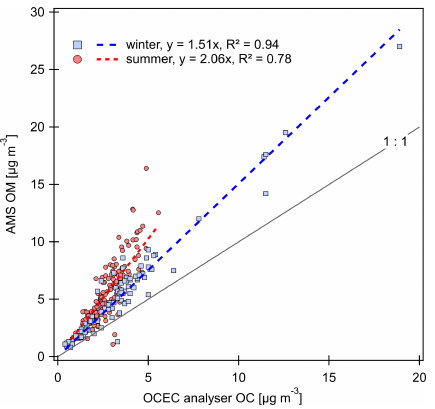
Figure A4. Comparison of organic mass concentration measured online by AMS (Org CE corrected) and by the OCEC analyser in summer and